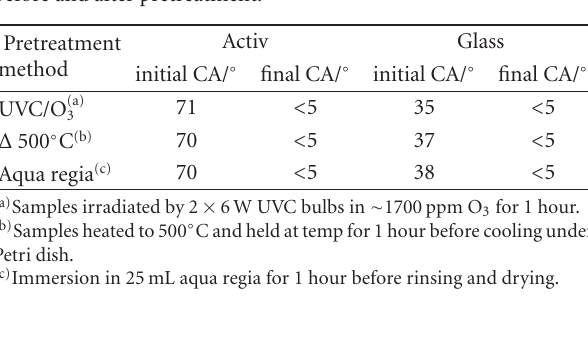
Figure 1: Plot of contact angle versus pretreatment temperature for Activ ( ◦ ) and for glass ( •